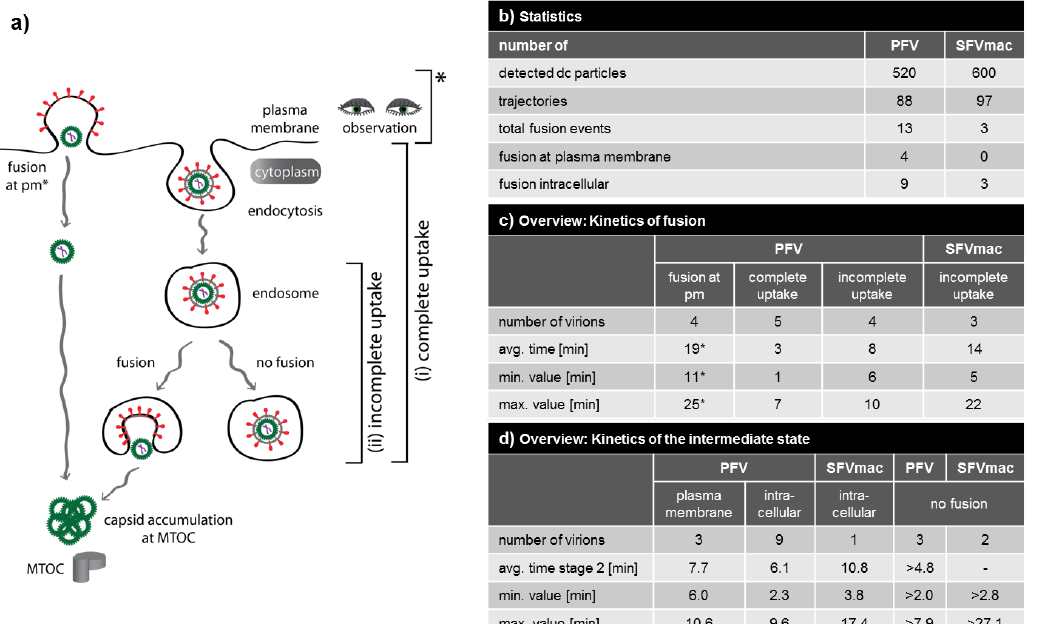
Figure 4. Overview of the detected fusion events. ( a ) Schematic illustration of the different types of fusions events detected during cellular uptake of dual-labeled FV particles. Events were classified into fusion at the plasma membrane and fusion from the endosome. Fusion events from an endosome were further divided into complete events (where the particle could be tracked from attachment at the plasma membrane until completion of the fusion from the endosome) and incomplete events for which the particle was only detected when it had already been taken up into an endosome. ( b ) Statistics of detected and tracked particles and detected fusion events. ( c ) Overview of the kinetics of fusion. * time at 37 ◦ C until fusion. ( d ) Overview of the kinetics of the intermediate